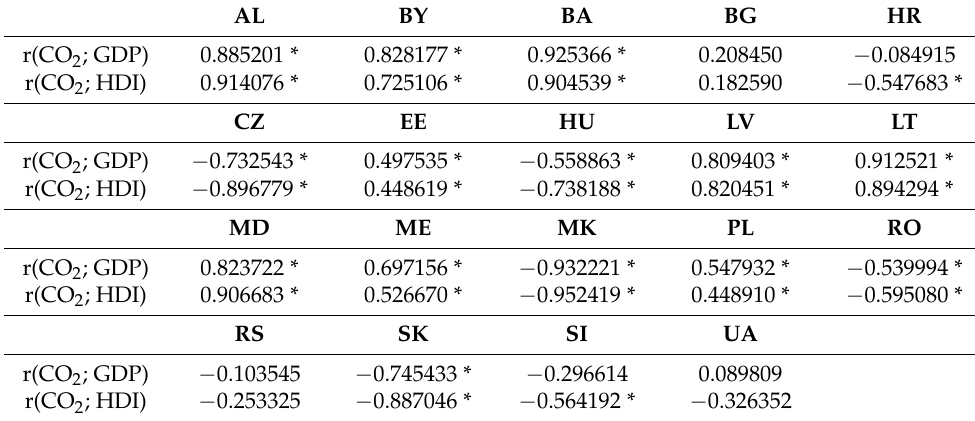
Table 3. Pearson correlation coefficient for the CEE countries.